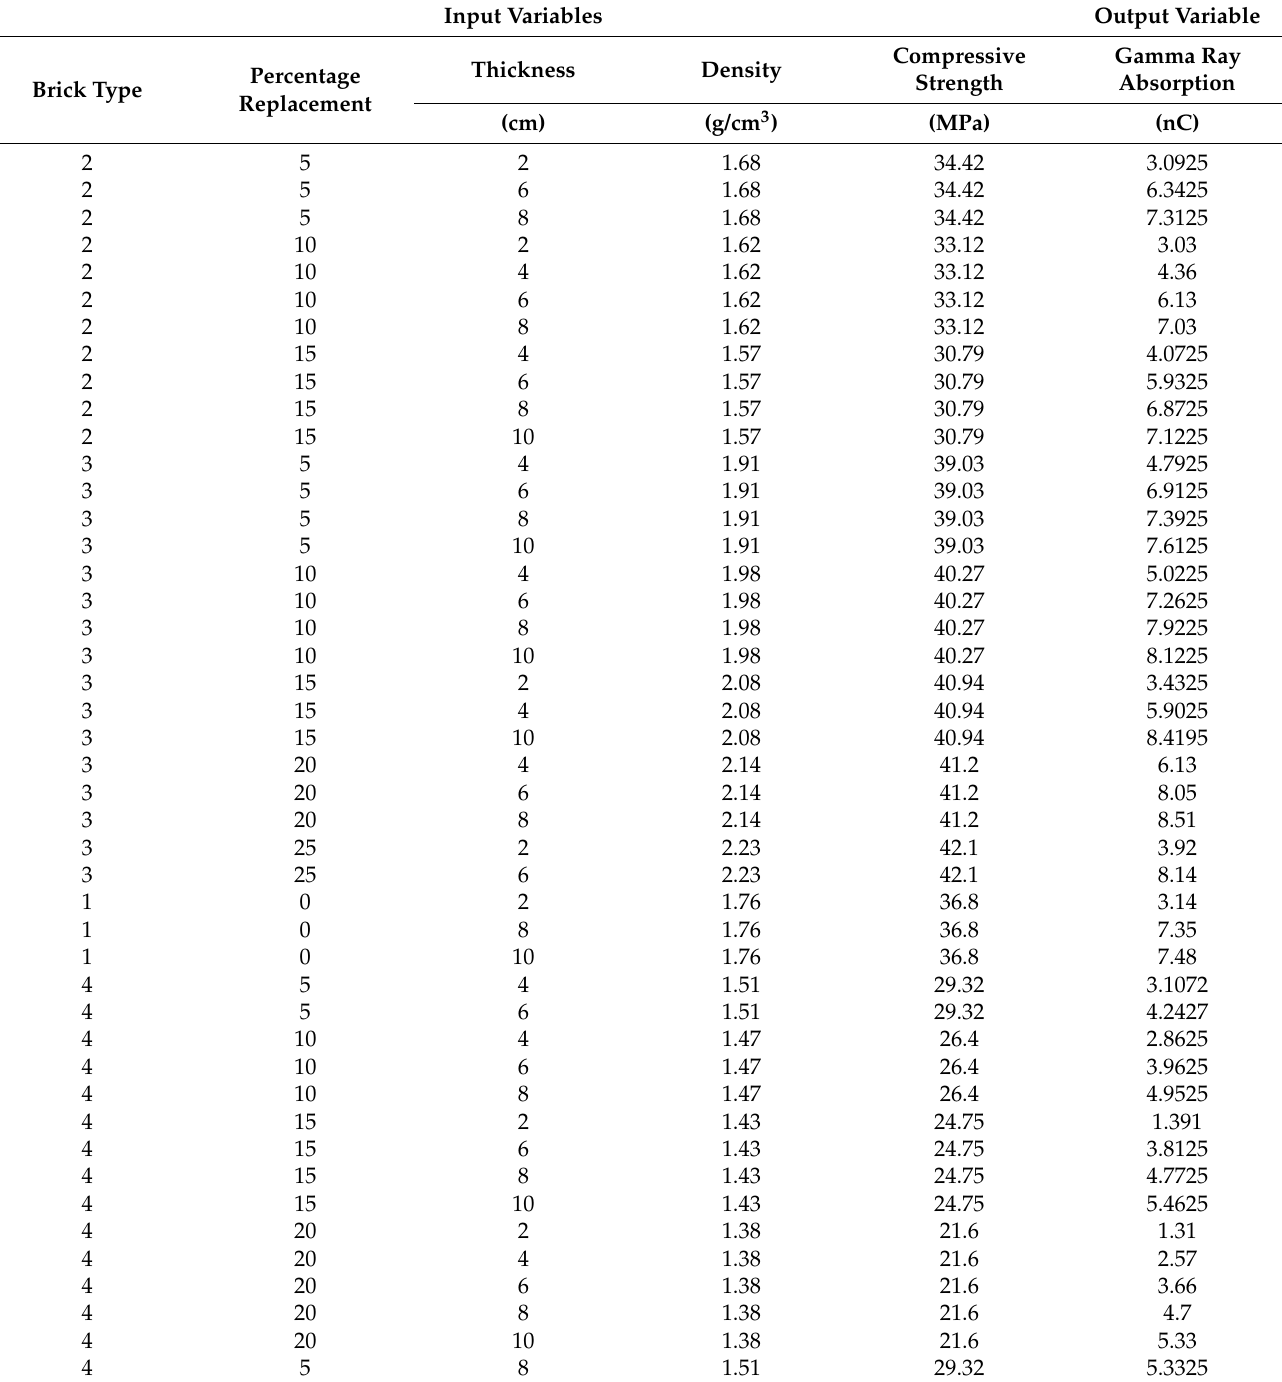
Table 6. Training dataset for model